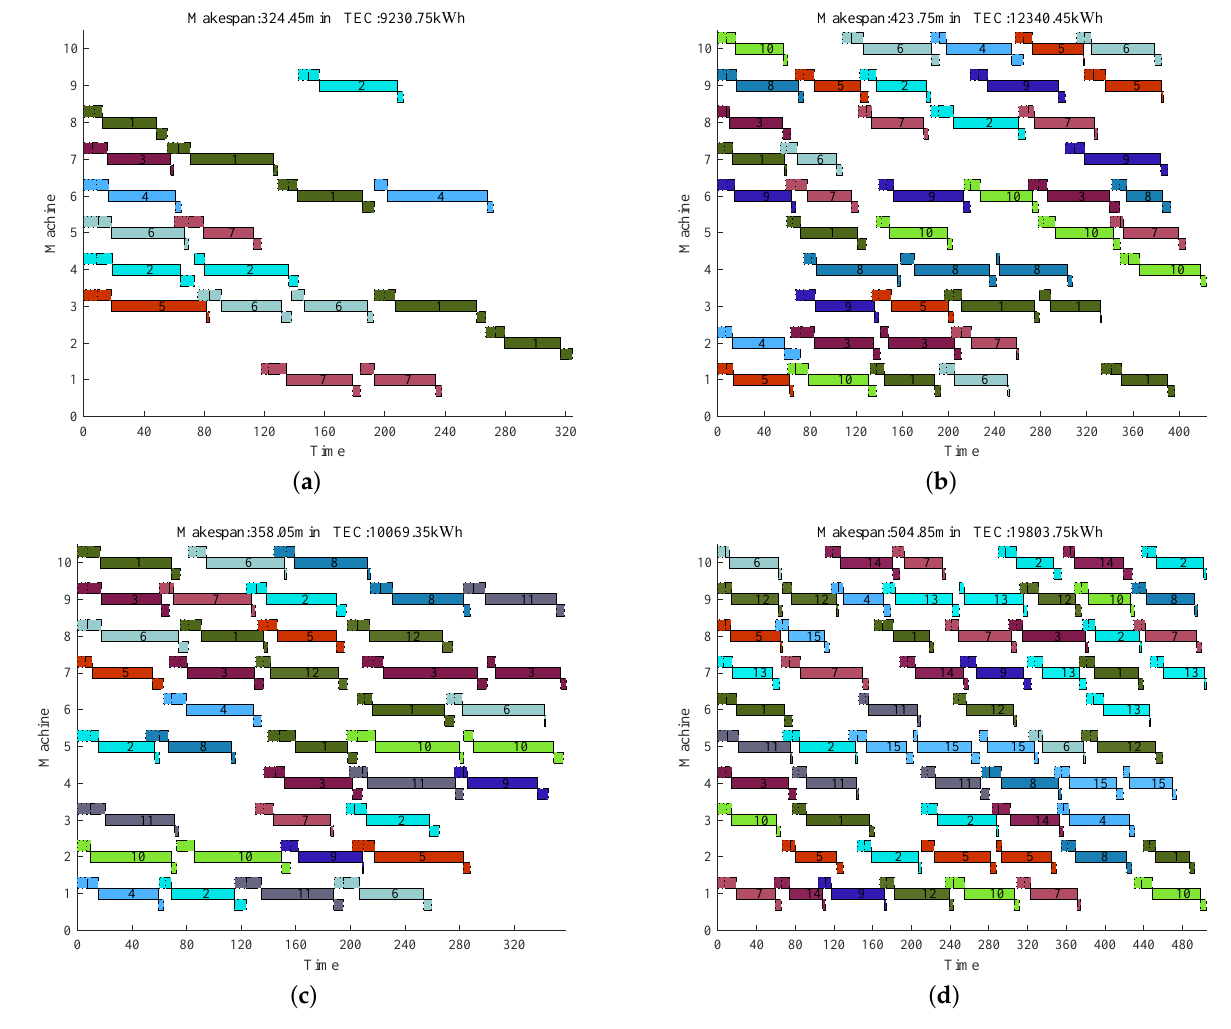
Figure 7. The Gantt chart of Instance 1–4 with the smallest energy consumption. ( a ) The Gantt chart of Instance 1; ( b ) the Gantt chart of Instance 2; ( c ) the Gantt chart of Instance 3; ( d ) the Gantt chart of Instance